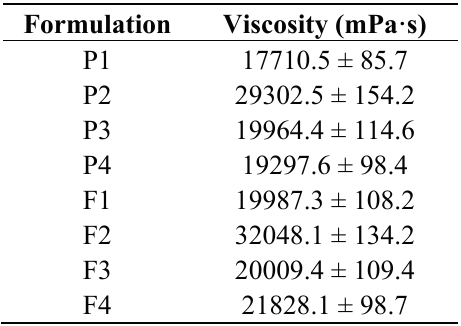
Table 1. Viscosity at 25 °C of the performed